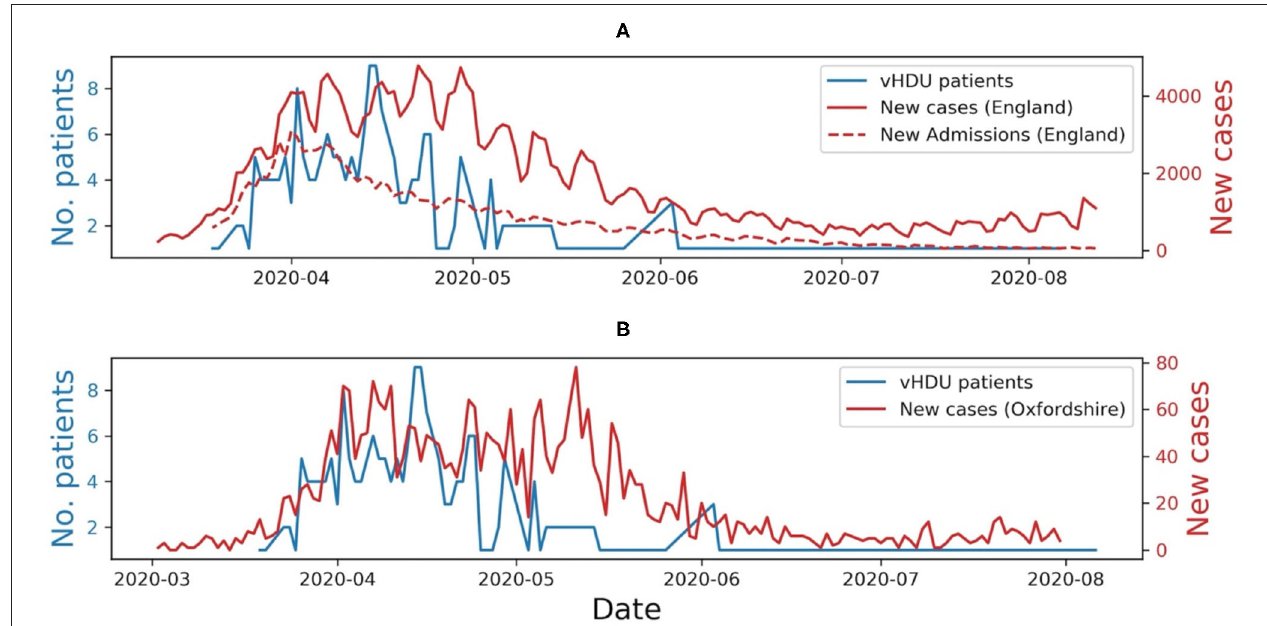
FIGURE 7 | (A) Number of COVID-19 patients monitored via the virtual High-Dependency Unit (vHDU) system in the John Radcliffe Hospital isolation ward vs. the number of new daily COVID-19 cases and new daily COVID-19 hospital admissions, in England, between the 20th of March and the 2nd of August 2020. (B) The number of new daily COVID-19 cases in Oxfordshire, is shown for comparison. It can be observed that the system usage followed the trend of the first wave of the pandemic in the